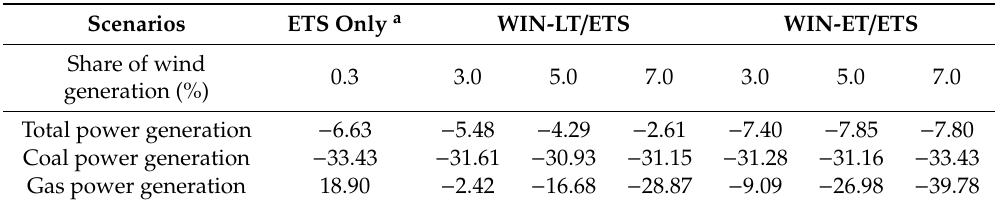
Table 17. Changes in the total fossil fuel generation source due to the increased wind power generation when there are emission regulations (% changes from the base year). Scenarios ETS Only